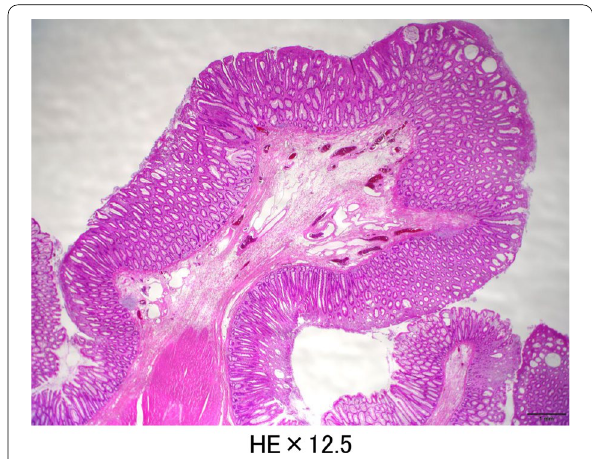
Fig. 3 Histopathological examination. There are multiple raised lesions from the descending colon to the rectum. Each lesion is covered with granulation tissue with inflammatory exudate in a hat-like manner, with hyperplasia of the crypt